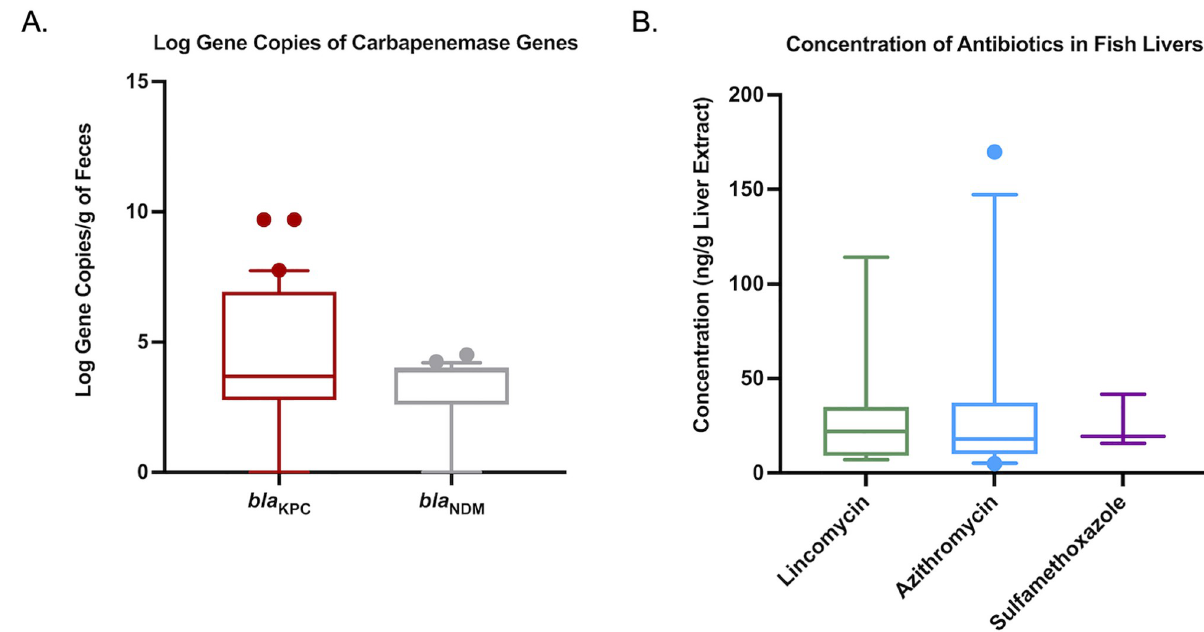
Fig 2. Box-and-whisker plots of concentrations of epidemic carbapenemase genes found in fish intestinal contents (A) and antibiotics (B) from liver extracts. The lower boundary of the box-and-whisker diagram indicates the 25 th percentile (Q1), the line within the box represents the median, and the upper boundary of the box represents the 75 th percentile (Q3). Error bars indicate 95 th and 5 th percentile values. Dots indicate values outside the upper and lower percentile limits. https://doi.org/10.1371/journal.pone.0272806.g002 Table 2. Logistic regression output used to determine associations between outcomes (Antimicrobial Resistant Bacteria and Antimicrobial Resistance Genes) and predictors (Distribution around WWTP sites, foraging group and exposure to antibiotics as determined by UHPLC-MS). Antimicrobial Resistant Bacteria (ARB) OR 95% CI P-value OR 95% CI P-value OR 95% CI P-value OR 95% CI P-value OR 95% CI P-value